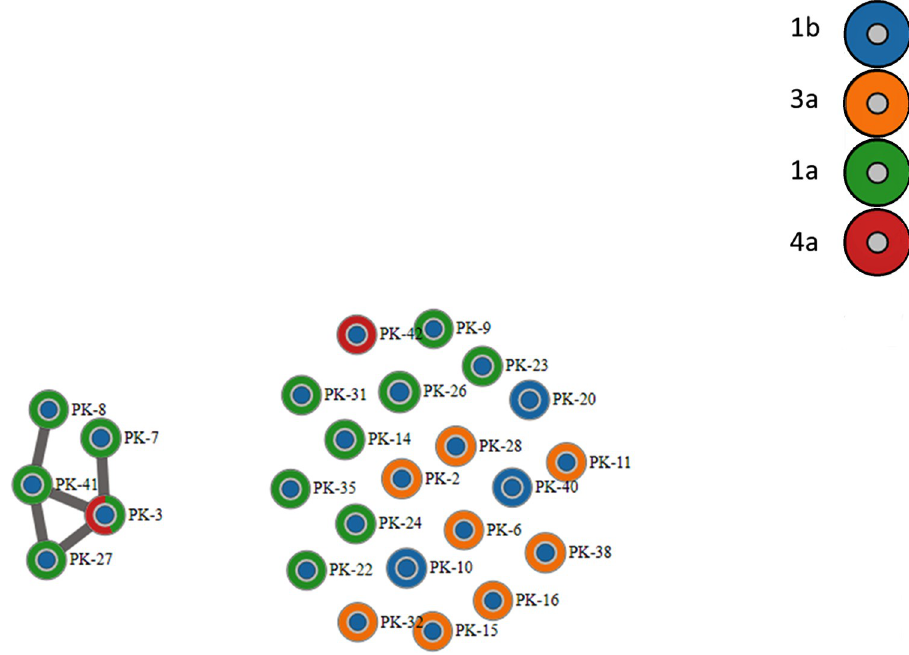
Fig 2. The GHOST HCV transmission network. Each node represents a person. Link is drawn if the minimal hamming distance between sequences from two samples is smaller than the established genetic relatedness threshold [20]. Genotypes are color-coded. Color of the node core identifies members of the transmission cluster (yellow) and unlinked cases (blue).